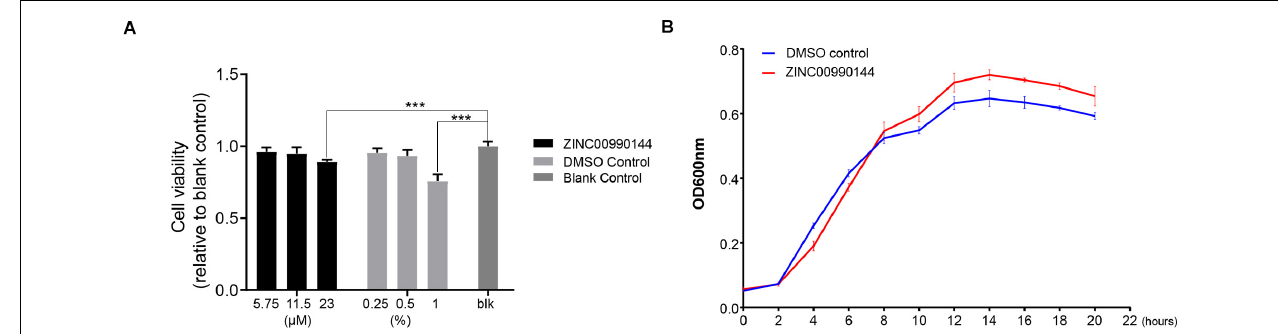
FIGURE 6 | Cytotoxicity of ZINC00990144 to HFF-1 cell line (A) and S. aureus (B) . (A) No significant difference detected between untreated (blank control) and treated group at 5.75 and 11.5 µ M concentrations of ZINC00990144 by CCK-8 assay. 23 µ M ZINC00990144 exhibits slight cytotoxicity which could be attributed to the solvent when comparing with the DMSO control. 5.75,11.5, 23 µ M ZINC00990144 contains 0.25, 0.5, 1% DMSO, respectively. (B) ZINC00990144 does not hamper the growth of USA300. *** P < 0.001 comparing to blank